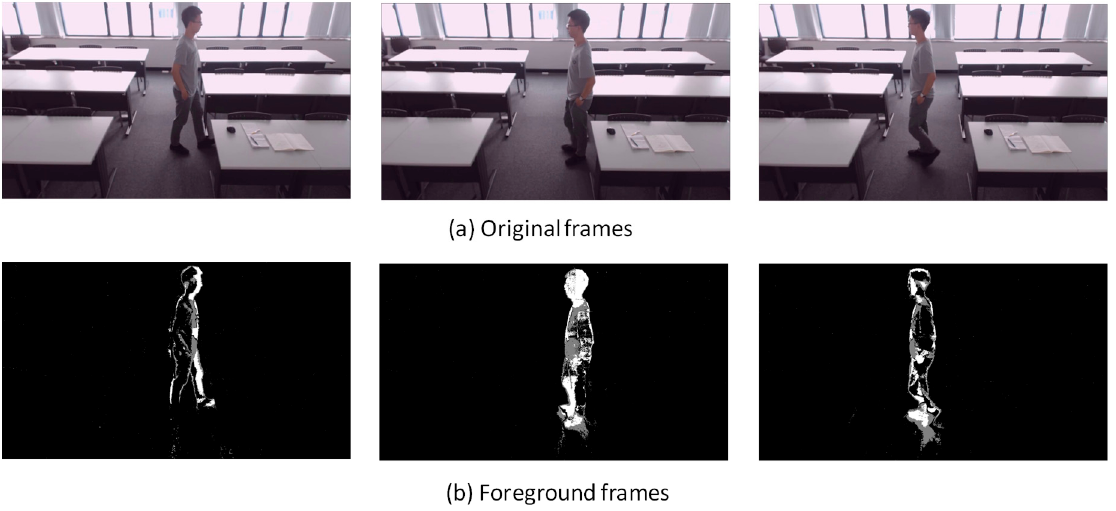
Figure 10. Walking about—sample images.